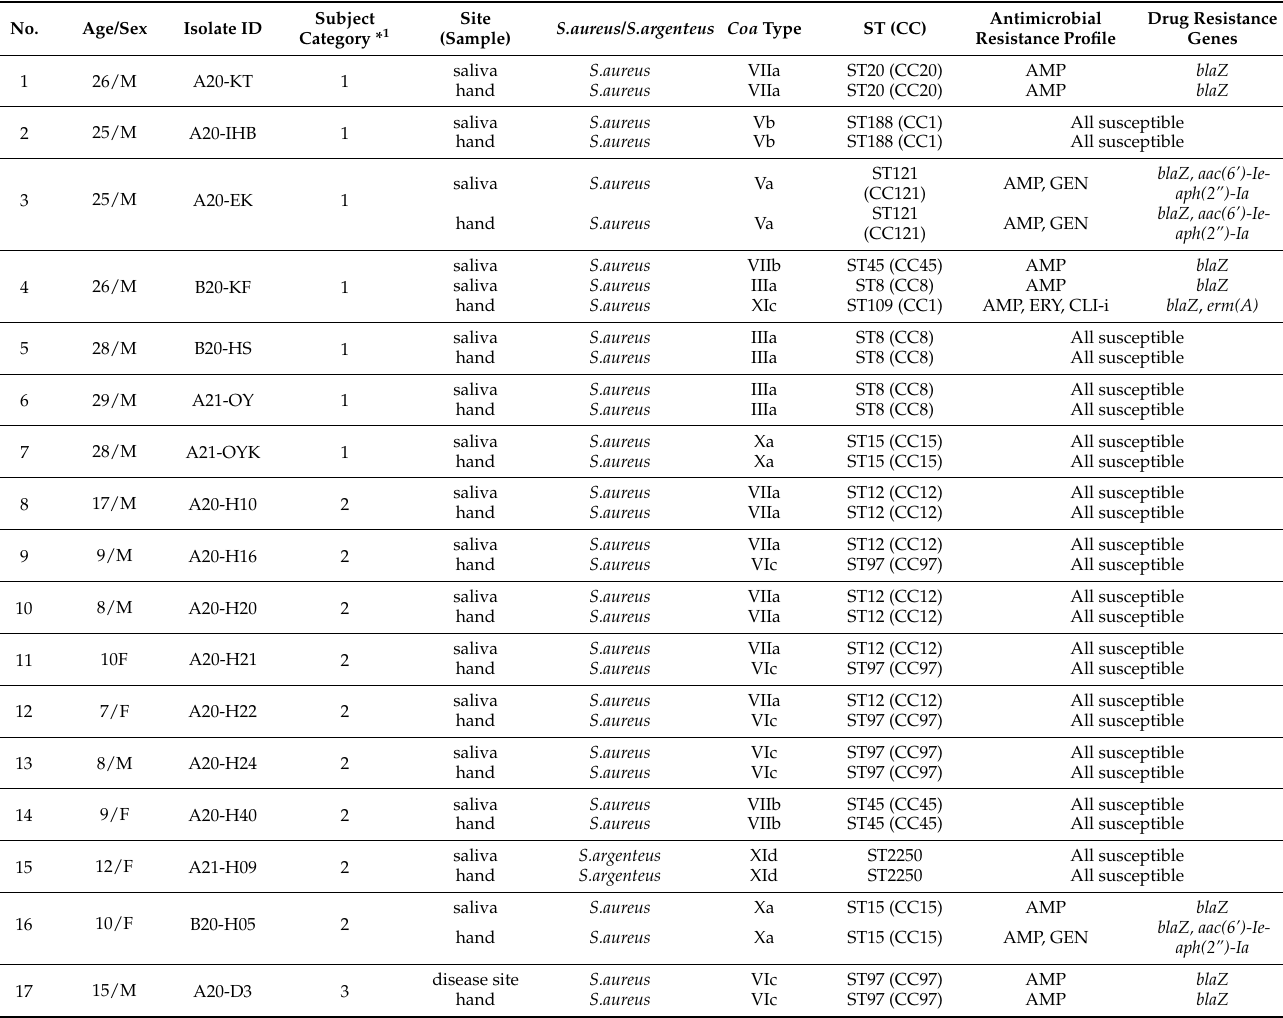
Table 3. Characteristics of S. aureus / S. argenteus isolated from both oral cavity and hand of subjects ( n = 19).